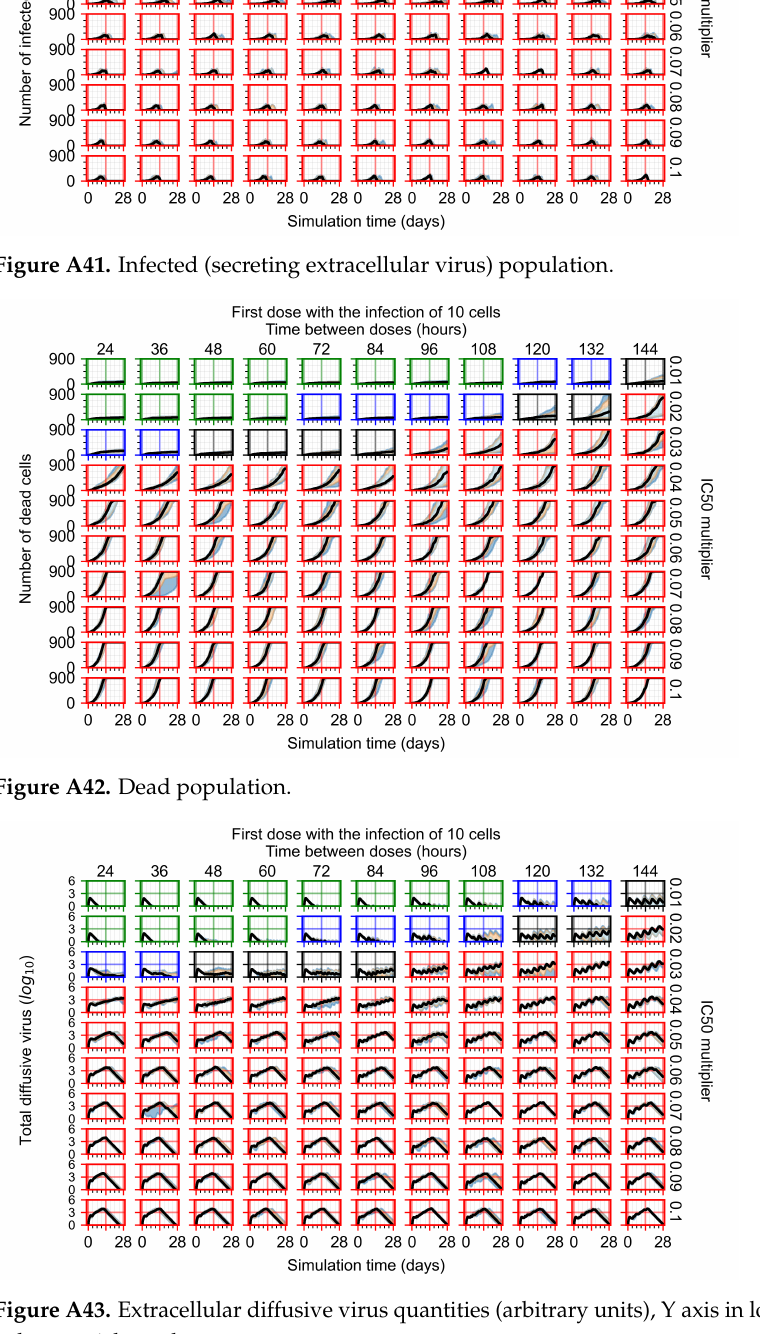
Figure A43. Extracellular diffusive virus quantities (arbitrary units), Y axis in log scale, and exponent values as tick